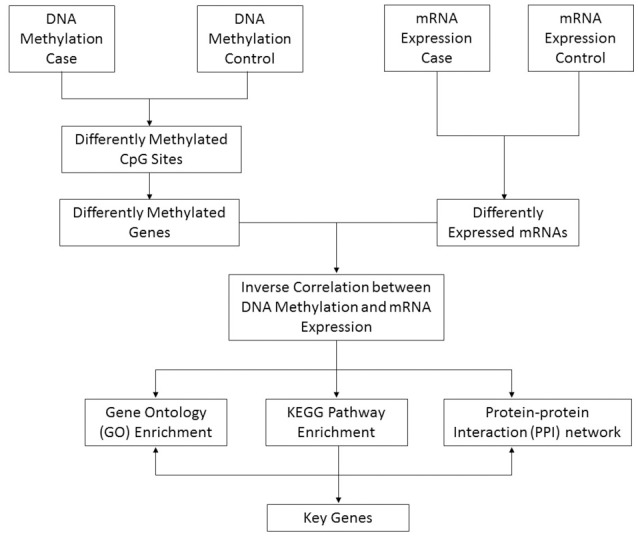
Schematic pipeline depicting the strategy of identification of key genes from DNA methylation and mRNA expression array integrative data. The method proceeds as follows steps: (1) Identify significantly differentially methylated genes and expressed genes in the case and control groups; (2) Retain those genes whose methylation and expression levels are highly anti-correlated; (3) Enrich the Gene Ontology, KEGG pathway, and PPI networks of anti-correlated genes; (4) Identify key genes from a combination of biological information, including interactions and relationships among genes, gene functional annotations and pathway maps.